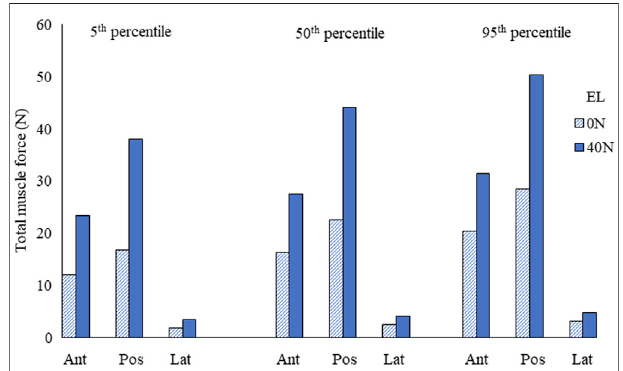
FIGURE 5 | Total muscle force in anterior/anterolateral (Ant), posterior/ posterolateral(Pos),andlateral(Lat)musclegroupsforthe5th,50th,and95th percentile segmental mass at 0 N and 40 N external load